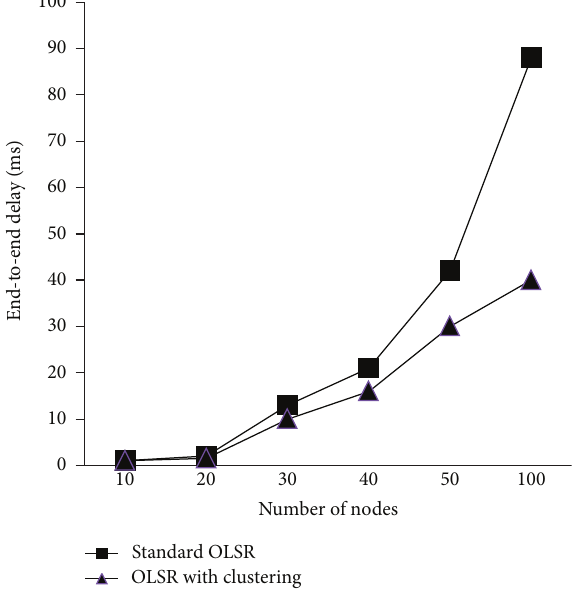
Figure 6: End-to-End delay versus number of nodes (CBR